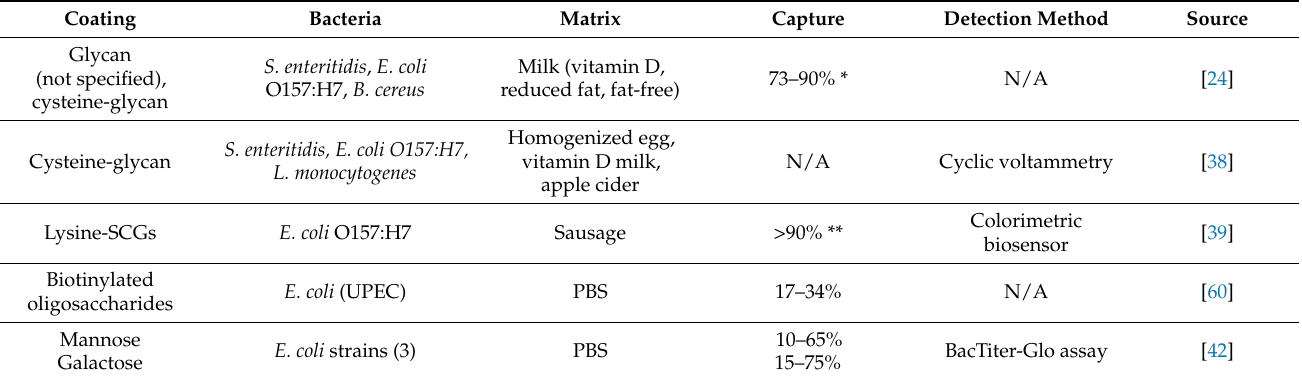
Table 2. Glycan-coated MNPs for extraction and concentration of foodborne pathogens.